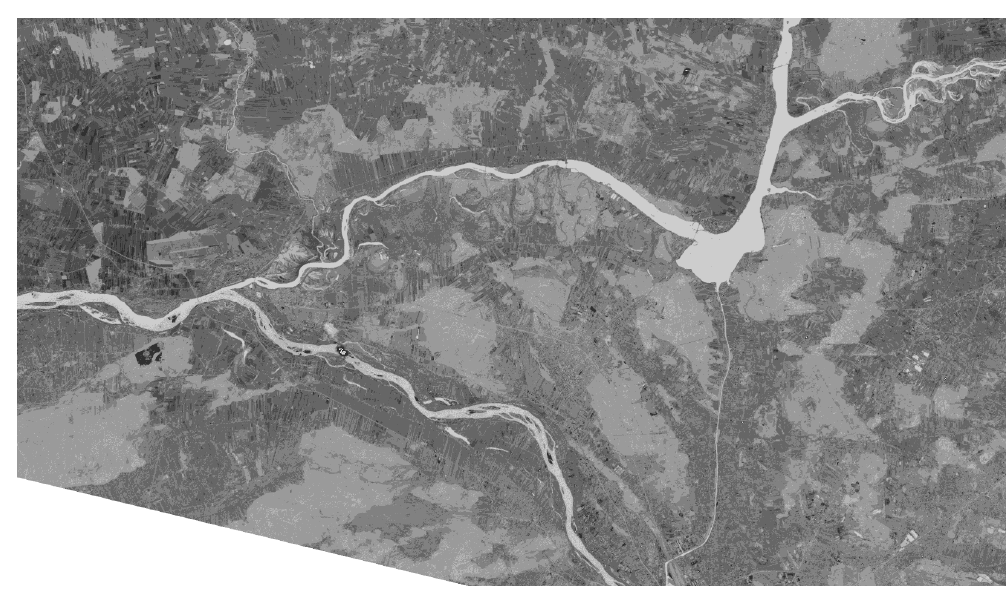
Figure 2. Visualization of the resulting image from the RS algorithm application exported as a 24-Bit depth geotiff image (greyscale).